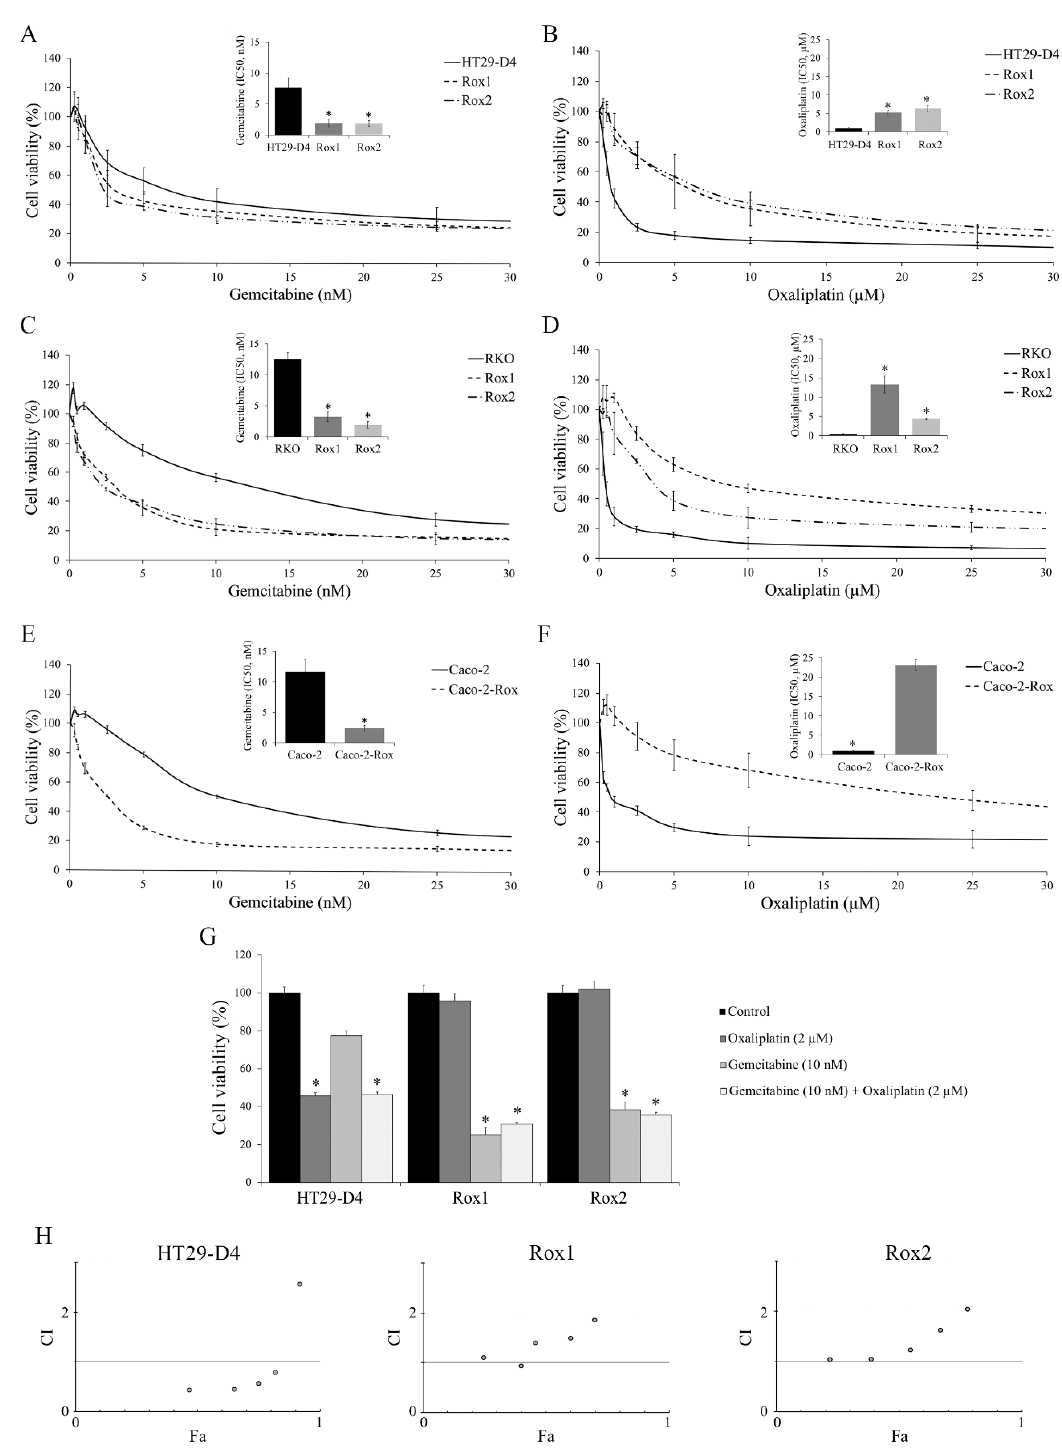
Figure 1. Characterization of the chemoresistance status of the cells and the effects of the gemcitabine/oxaliplatin combination. ( A ), ( C ), and ( E ) Effects of gemcitabine on HT29-D4, RKO, and Caco-2 viability, respectively. IC 50 values are presented in the corners. ( B ), ( D ), and ( F ) Effects of oxaliplatin on HT29-D4, RKO, and Caco-2 viability, respectively. IC 50 values are presented in the corners. ( G ) Effects of oxaliplatin and gemcitabine, used alone or in combination, on the viability of HT29-D4, Rox1, and Rox2 cells. ( H ) Combination status of oxaliplatin and gemcitabine in HT29-D4, Rox1, and Rox2 cells (Chou–Talalay method). Combination indexes (CI) are plotted on the y -axis as a function of the affected fraction (Fa; x -axis). CI < 1, CI = 1, and CI > 1 indicate synergism, additivity, and antagonism, respectively. Asterisks indicate statistical significance with p <